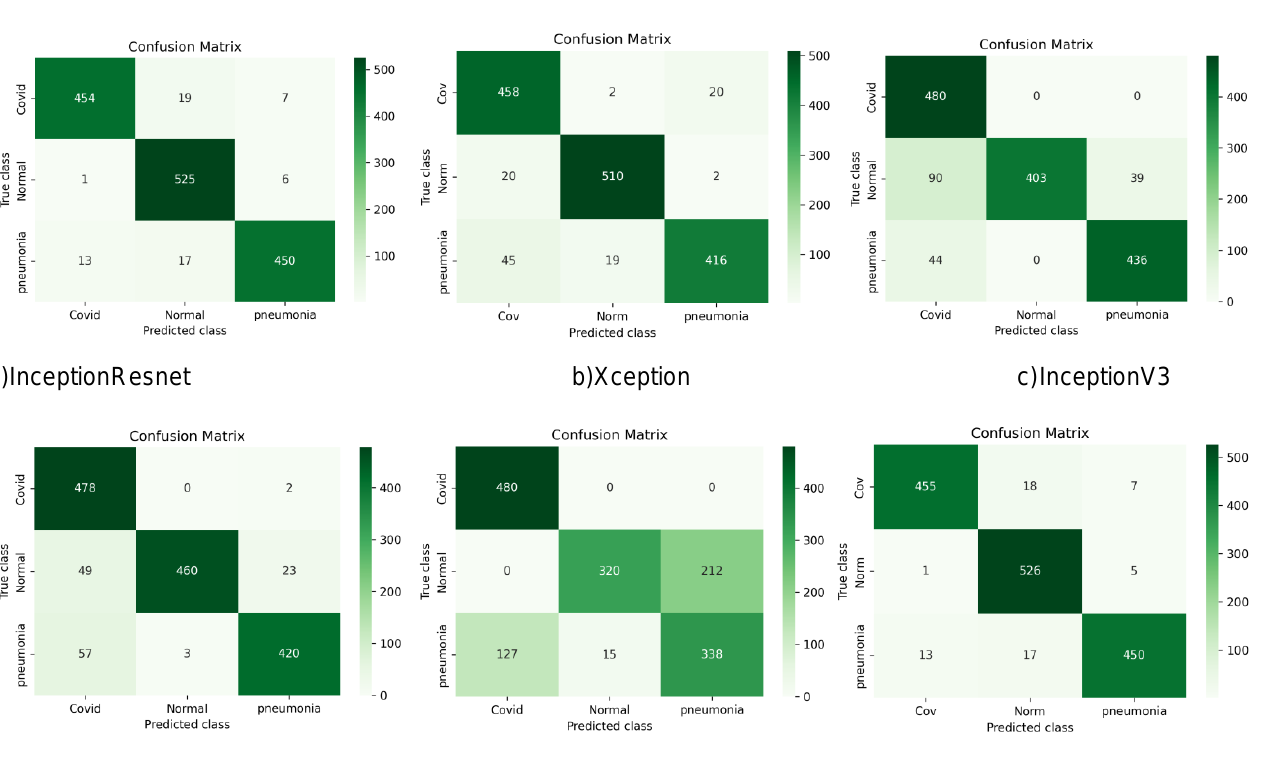
Figure 8. CT Scan classification confusion